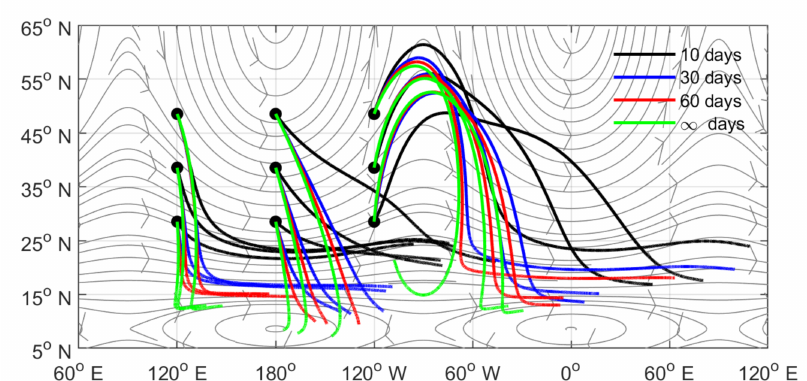
Figure 1. Ray paths of the 10 day (black), 30 day (blue), 60 day (red) and stationary waves (green). The streamlines represent the analytical basic flow. The black points are the wave sources located along the jet stream. The point locations are 120 ◦ E, 28.5 ◦ N; 120 ◦ E, 38.5 ◦ N; 120 ◦ E, 48.5 ◦ N; 180 ◦ , 28.5 ◦ N; 180 ◦ , 38.5 ◦ N; 180 ◦ , 48.5 ◦ N; 120 ◦ W, 28.5 ◦ N; 120 ◦ W, 38.5 ◦ N; 120 ◦ W, 48.5 ◦